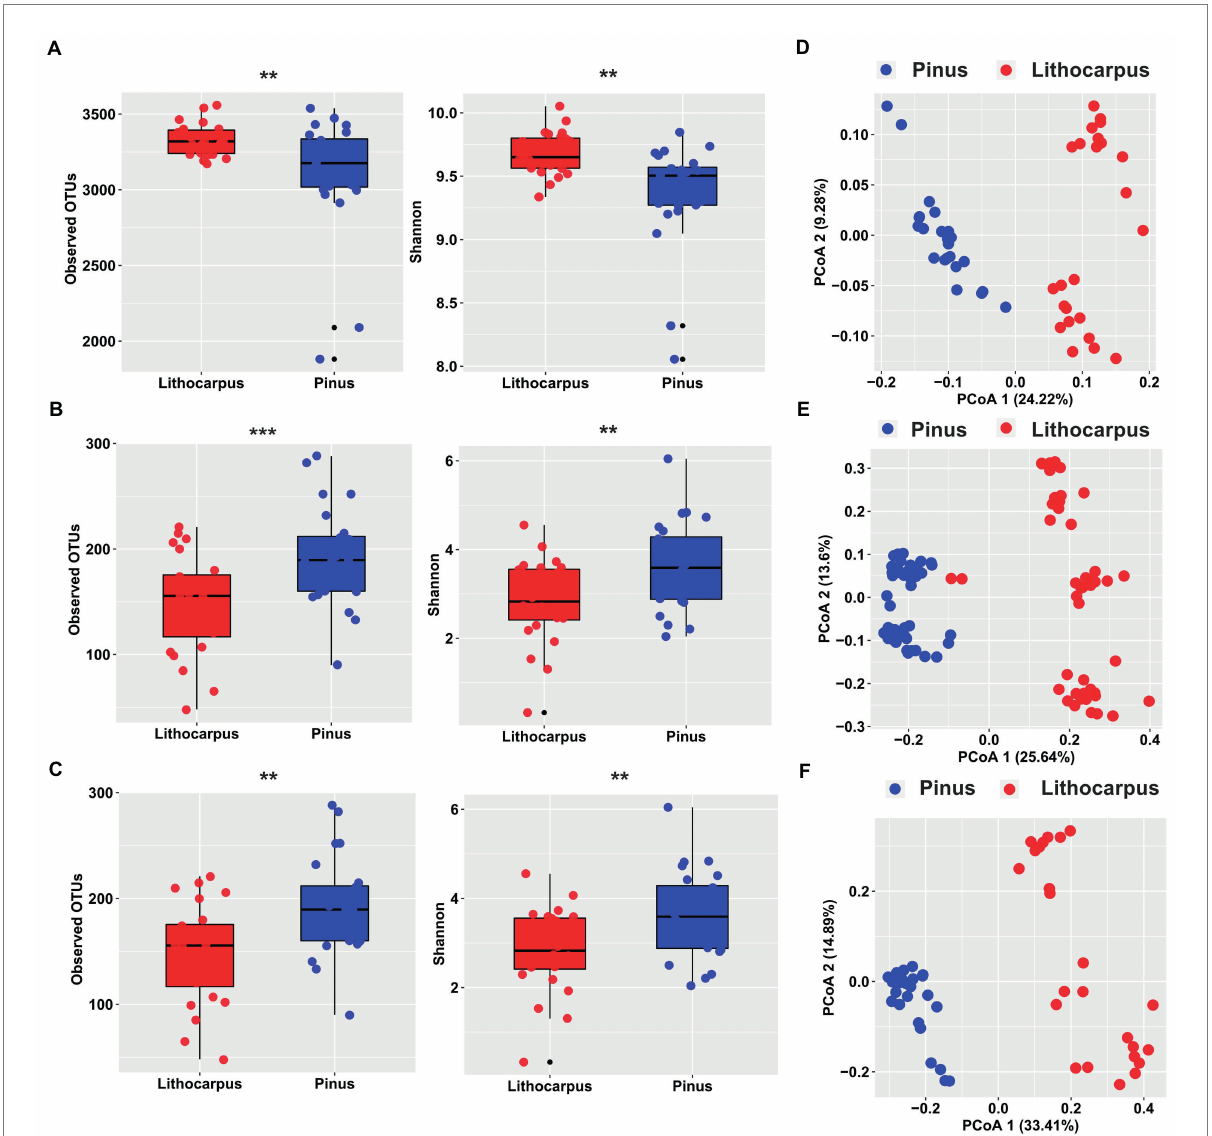
FIGURE 1 Diversity of bacterial and fungal communities associated to Lithocarpus and Pinus ECM roots. Alpha-diversity measurements are based on the observed OTUs and Shannon index for the bacterial (A) and fungal ( B , ITS1; C , ITS2) microbiomes. Unconstrained PCoA for beta-diversity using Bray-Curtis distances in bacterial (D) and fungal ( E , ITS1; F , ITS2) communities identified in Lithocarpus and Pinus ECM roots. Statistical data analyses were performed using one-way ANOVA (** p < 0.01, *** p < 0.001). For the alpha-and beta-diversity analyses based on ITS1 sequences we used samples collected during both the dry and wet seasons, while for the analyses based on ITS2 sequences we only used the samples collected during the wet